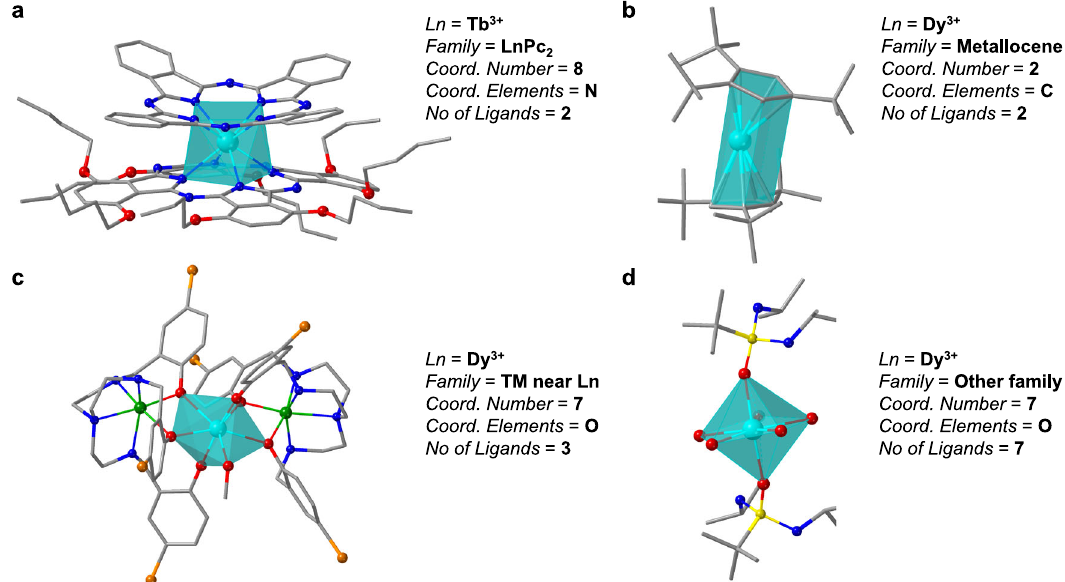
Fig. 2 | Molecular structures of some representative lanthanide-based SIMs fromdifferentchemicalstrategiesandsomeoftheirchemicaldescriptors.a Pc doubledeckers,abbreviatedasLnPc 2 ( T hyst =2K) 72 . b MetallocenecomplexLnCp* 2 ( T hyst =60K) 42 , see Supplementary Information 1 for our CN criterion for the metallocene family. c A complex with the introduction of a diamagnetic TM ion near the lanthanide ion, [Zn 2 DyL 2 (MeOH)] − (L is a tripodal ligand, 2,2 ’ ,2 ” -